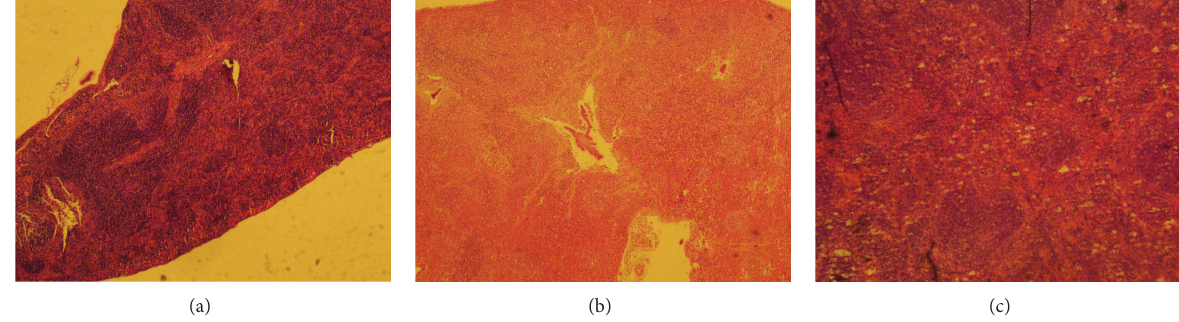
Figure 4: Pathology evaluation of spleen on d60 in mice with untreated (a), BMF (b), or OCH (c). On d60 after BMF induction, mice were sacrificed. Spleens were collected, fixed, embodied, sectioned, stained with H&E, and examined by using an Olympus microscope.